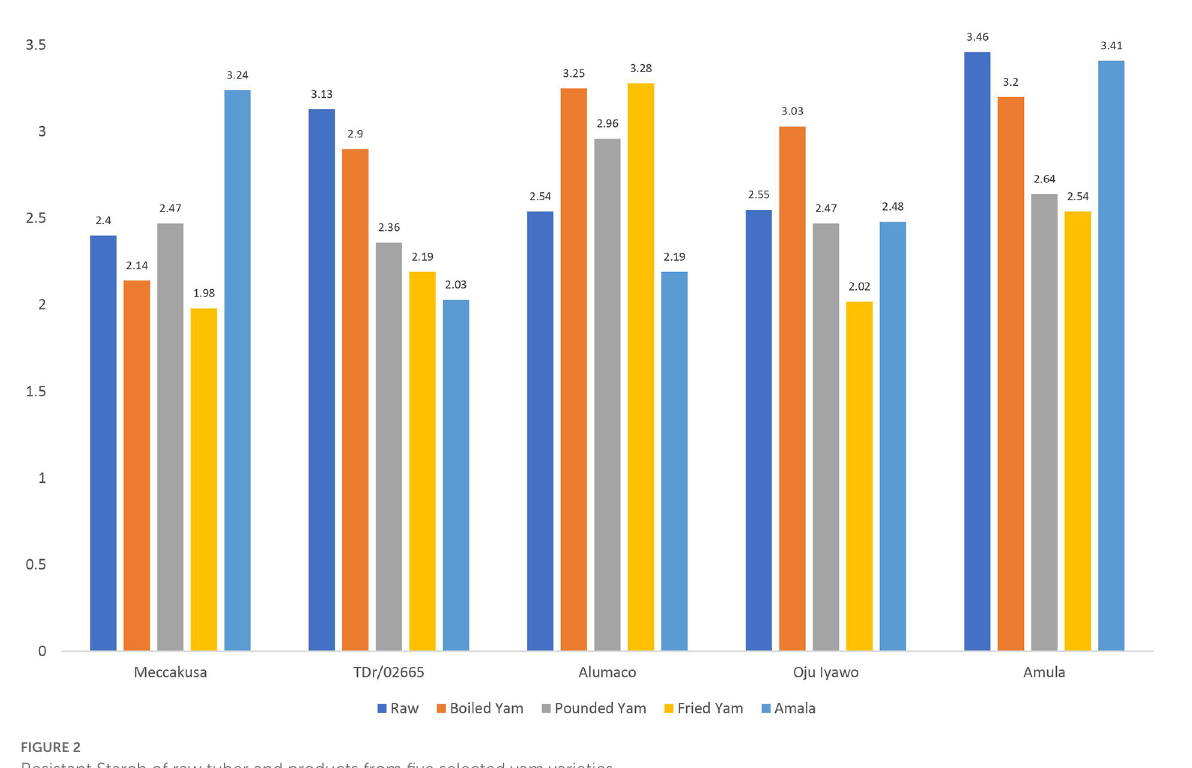
FIGURE2 Resistant Starch of raw tuber and products from five selected yam varieties.